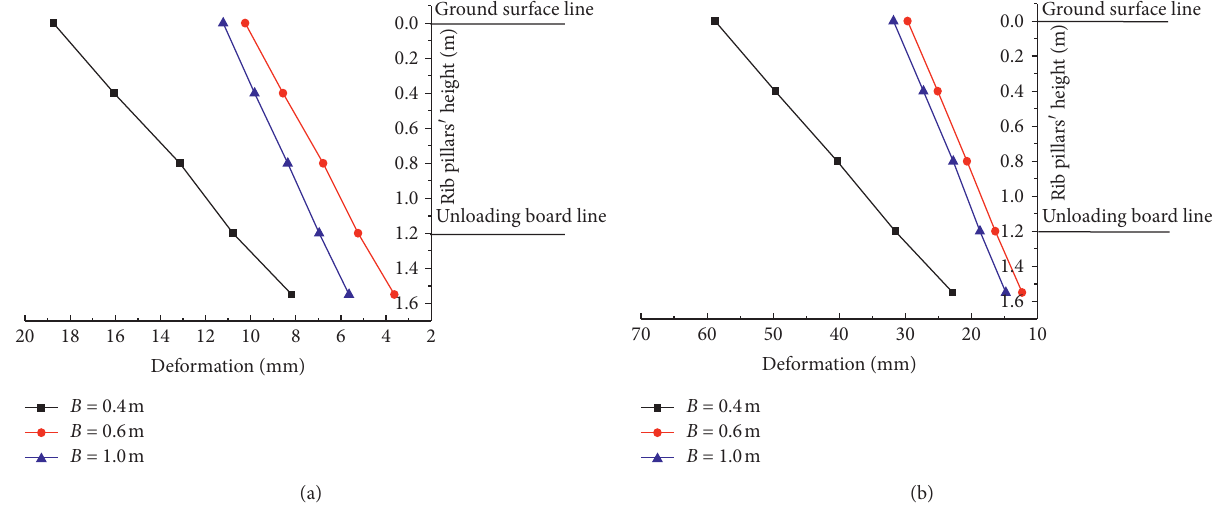
Figure 12: The variation curve of the deformation of rib pillars with the wall body at the external load: (a) h � 1.2m ( p � 10kPa) and (b) h � 1.2m ( p �